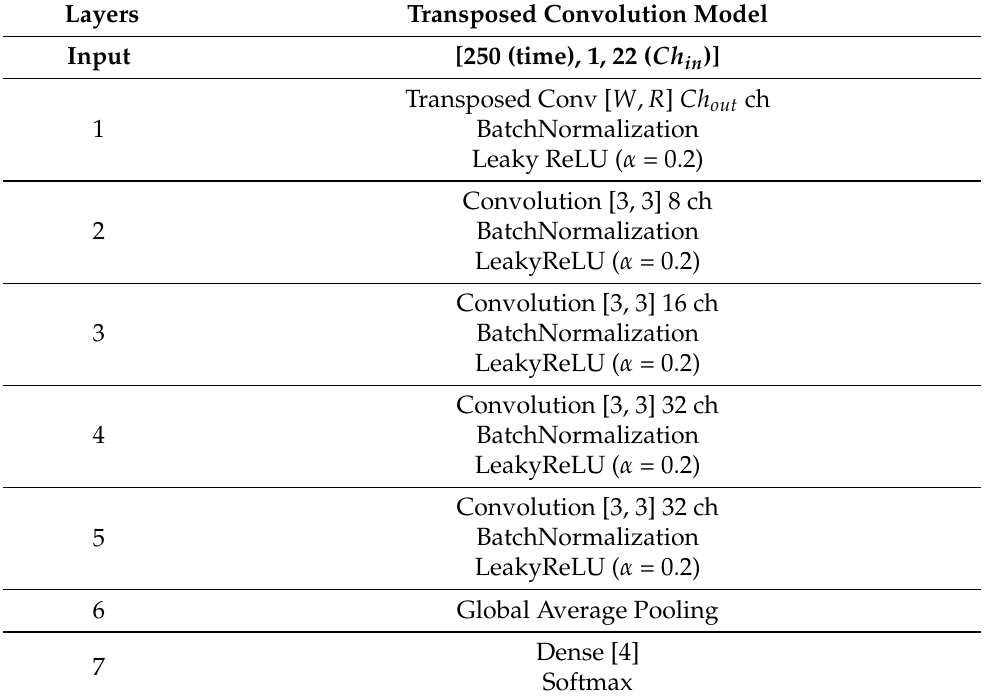
Table 8. Model structure for parameter search.